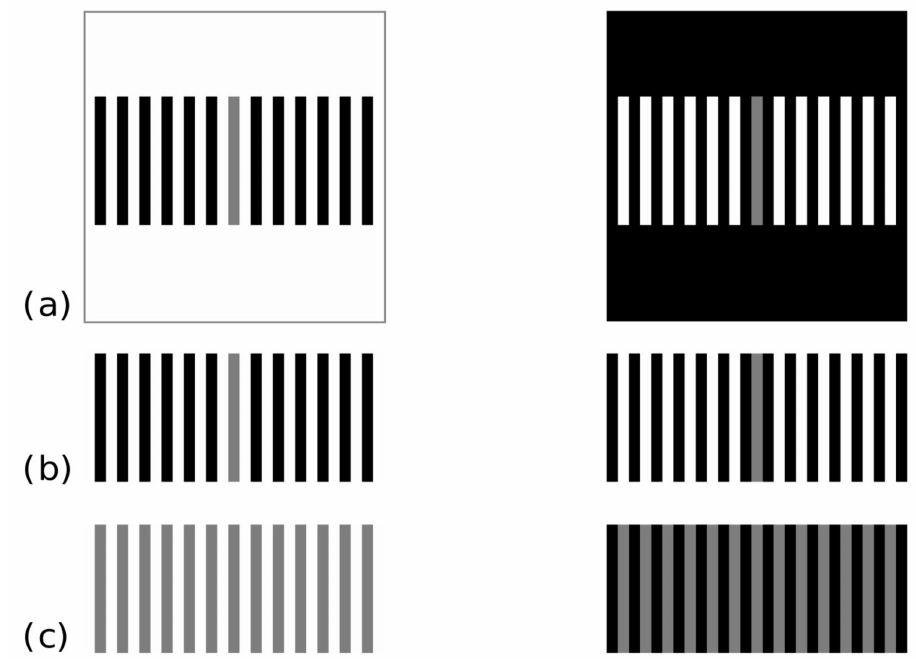
Figure 1. ( a ) Gilchrist and Annan’s [21] original reversed contrast configuration; ( b ) same configuration with a reduced background: removing the global belongingness / grouping factor, the e ff ect is still that of reversed lightness contrast, as modified by Agostini et al. [25]; ( c ) same configuration with reduced background and with only gray strips: this is the classical assimilation configuration by Helson